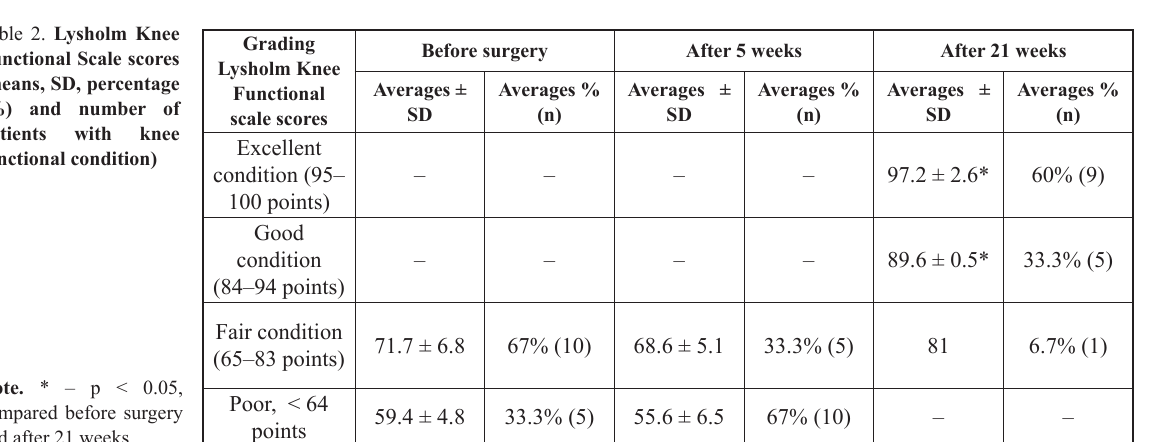
Note. * – p < 0.05, compared before surgery and after 21